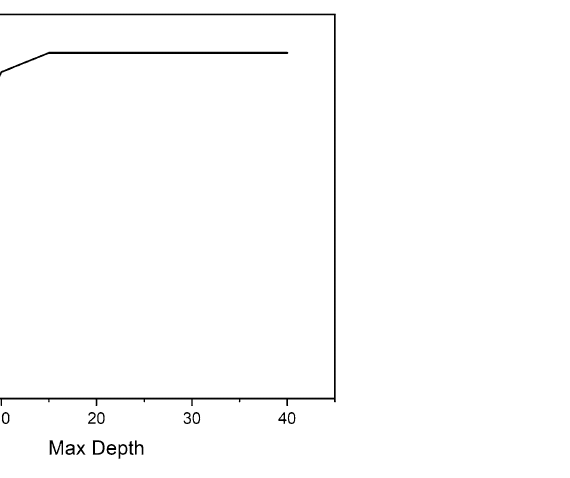
Figure 9. Effect of Max depth on RF